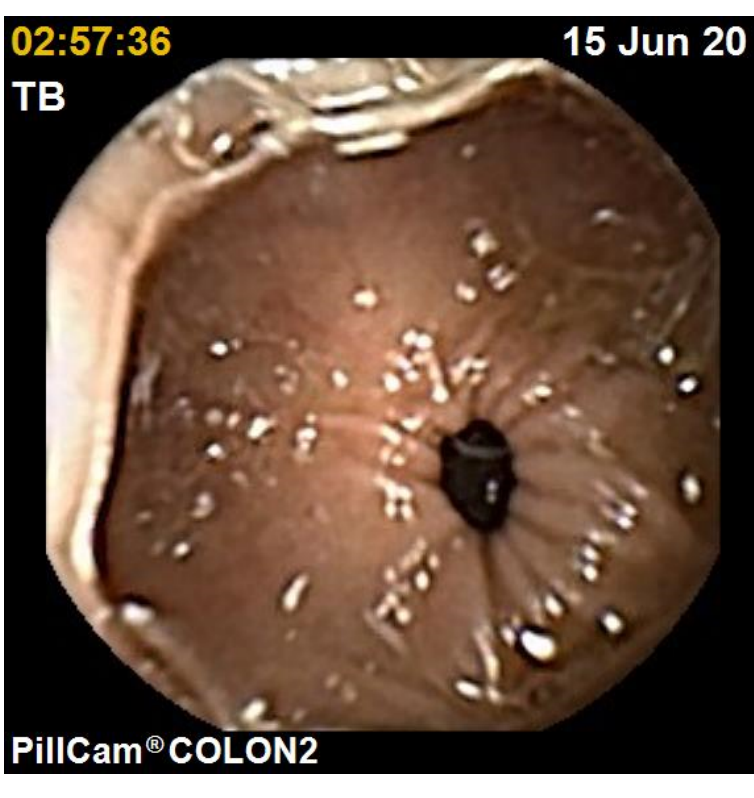
Figure 1. Normal colon.